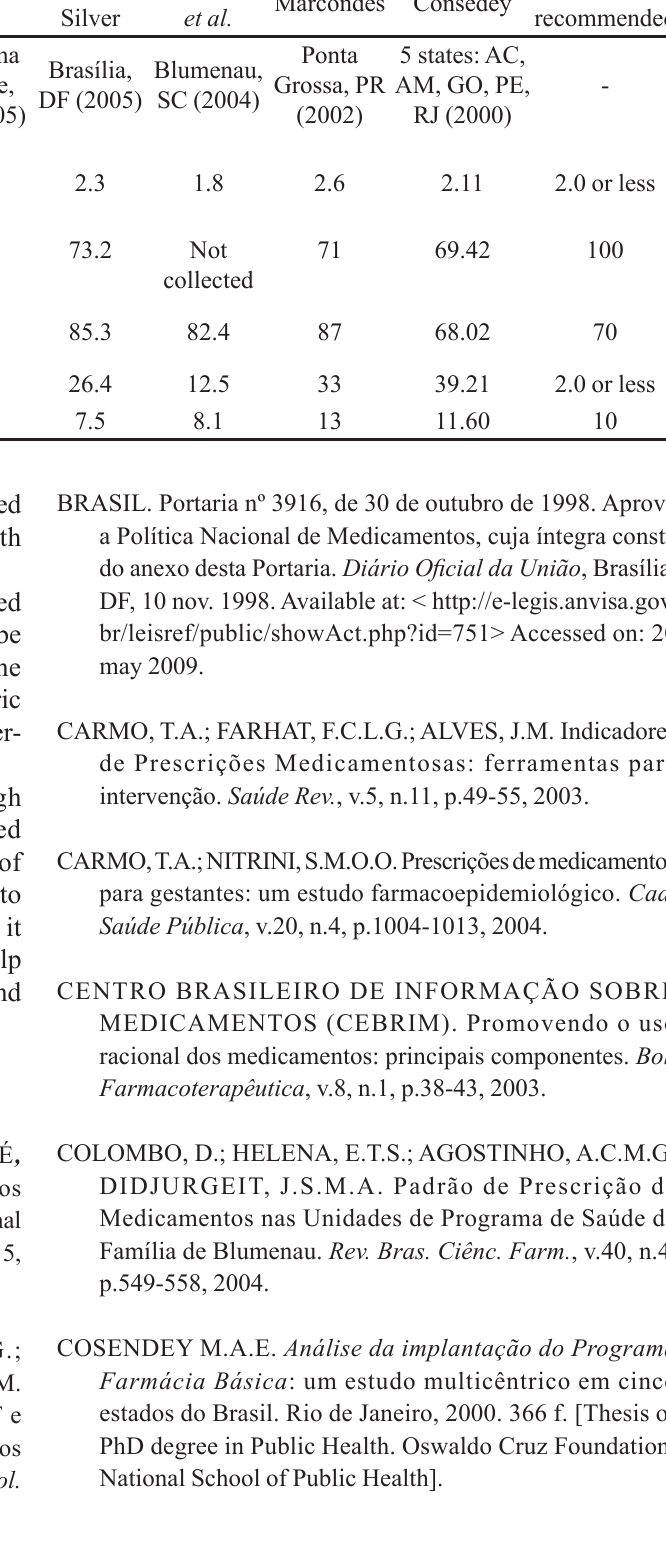
TABLE VI - Comparison between studies conducted in different cities of Brazil Authors